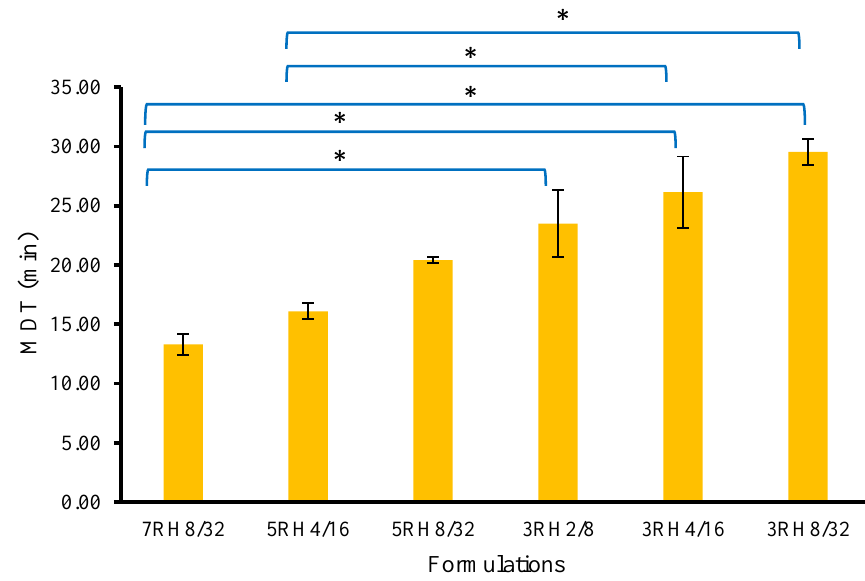
Figure 5. The mean dissolution times (MDTs) of the selected dry MIPEs (3RH2/8, 3RH4/16, 3RH8/32,